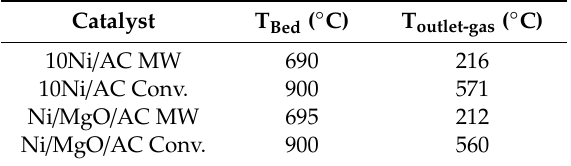
Table 2. Temperatures of the beds and product gases for microwave and conventional heating reactors.